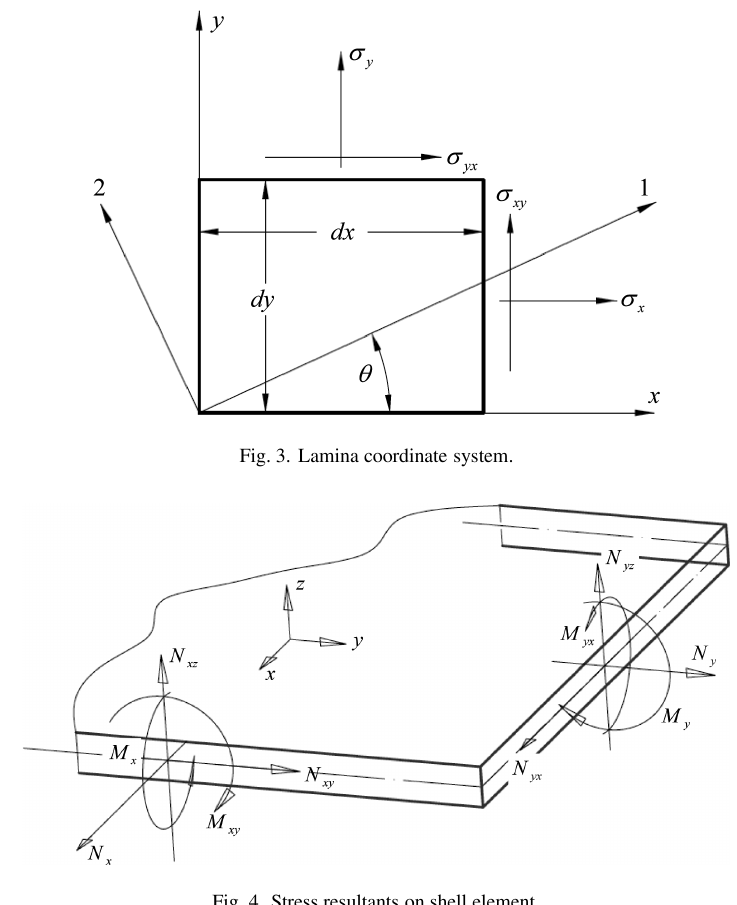
Fig. 4. Stress resultants on shell